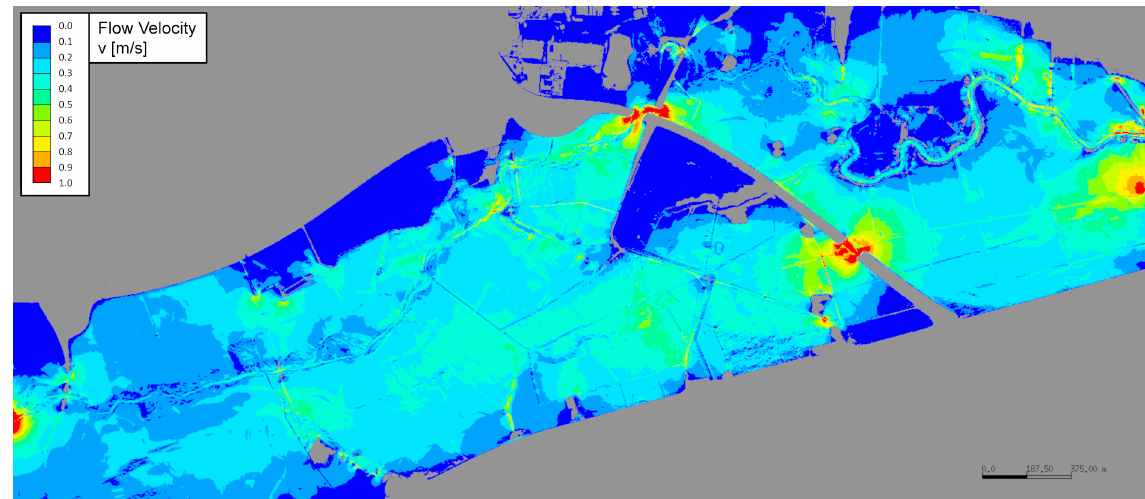
Figure 11. Flow velocities for the stationary state. Grey indicates dry areas.